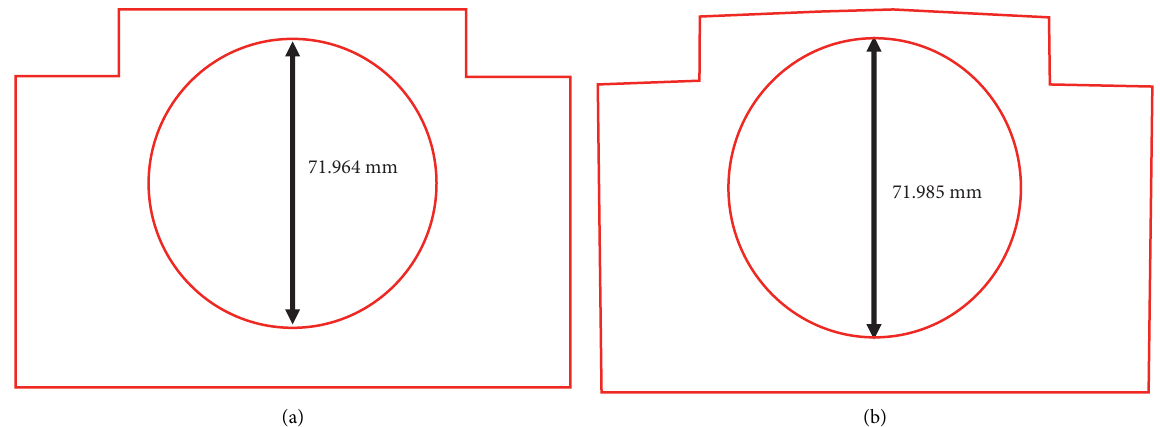
Figure 9: Deformation of bearing housing: (a) without deformation and (b) with deformation based on Figure 8(c) (note that the enlarged scale is 200).